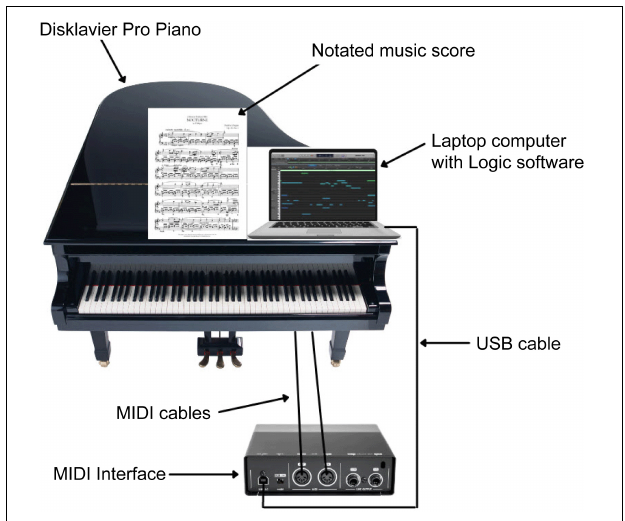
FIGURE 3 | Schematic drawing of the